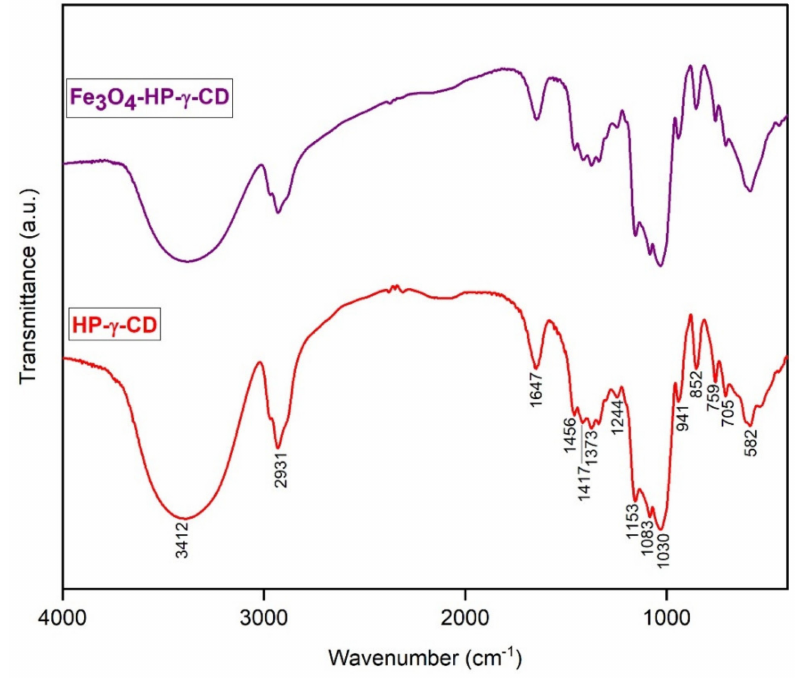
Figure 11. FT-IR spectra of HP- γ -CDs and Fe 3 O 4 -PAA–(HP- γ -CDs). The other allocations of bands are as follows: around 1640 cm − 1 is the deformation band of water H-O-H; the band at 1459 cm − 1 shows the in-plane bending of CH 3 ; the band at 1362 cm − 1 corresponds to in-plane bending of CH, enolic COH, and skeletal CCC. The characteristic wide band with peaks at 1155, 1082, and 1030 cm − 1 can be allocated to CH overtone stretching + C–O–C stretching, C–O,C–C stretching + in-plane bending of OCH, and C–O, C–C, CCO, and C–O–C stretching of glucose units, respectively. There are still few bands under 1000 cm − 1 : at 944 cm − 1 , correlated with O stretching and in-plane bending of CCH; at 855 cm − 1 , corresponding to CH out-of-plane bending of aromatic CCH and skeletal CCH; and at 753 cm − 1 , allocated to CH out-of-plane bending and skeletal C-C stretching. The position of the absorption bands presented by Singh is very similar to the ones obtained by us and are presented in Figure 11.